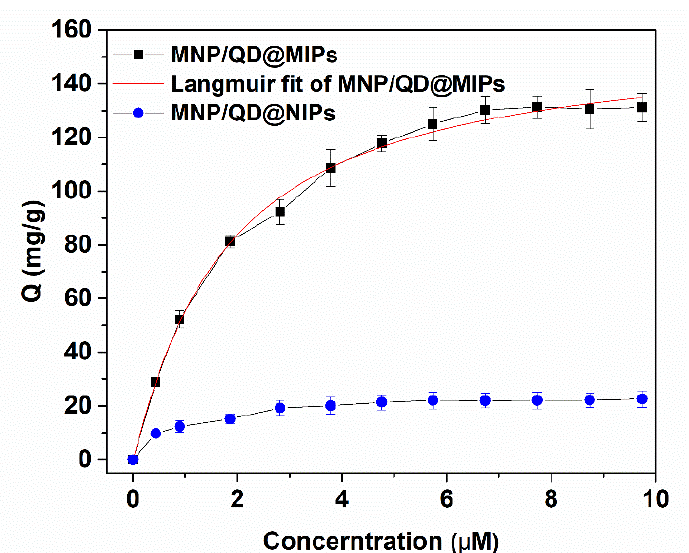
Figure 5. Binding isotherm and Langmuir fit of MNP/QD@MIPs and MNP/QD@NIPs.